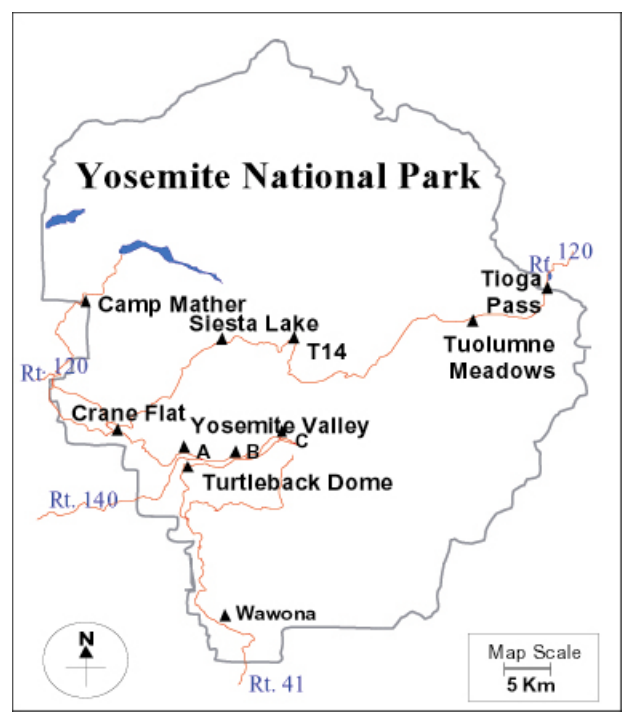
FIGURE 8. Locations of passive monitoring sites in Yosemite NP. Sites are accessible by a hike within 15 min of the roads. The sampling poles are placed out of direct public view.